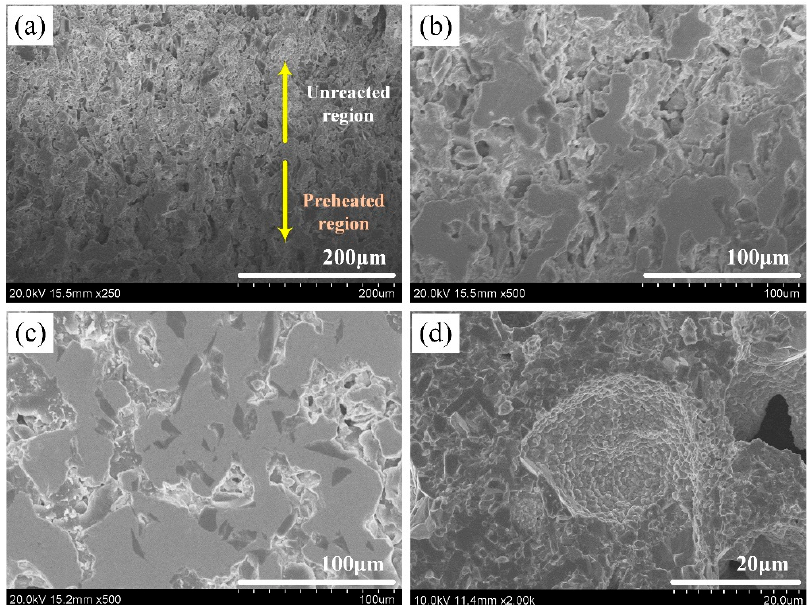
Figure 12. Microstructure of the ( a ) interface between the unreacted region and the preheated region, ( b ) preheated region, ( c ) reacting region, ( d ) fully reacted region, respectively.